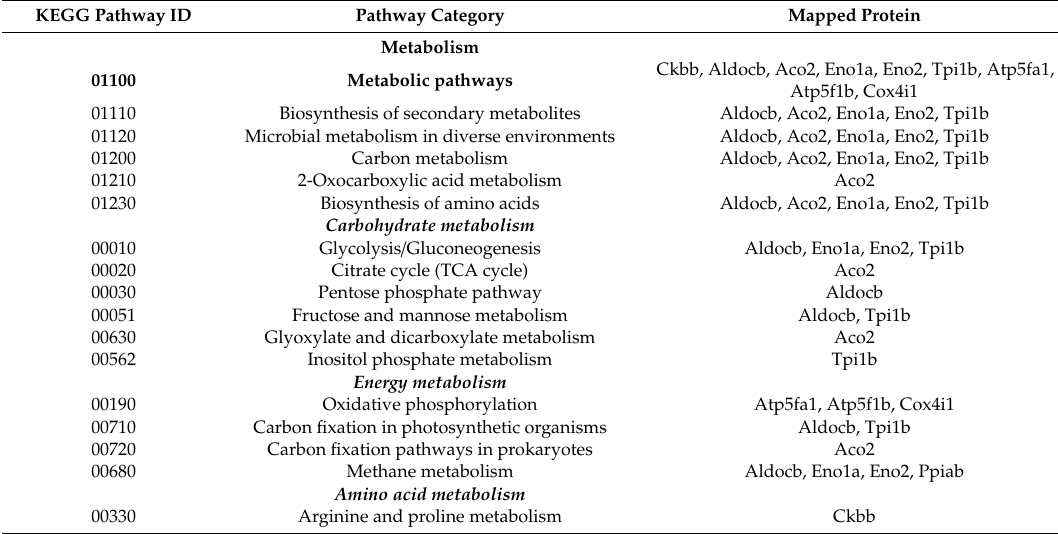
Figure 10. BiNGO result for molecular function as visualized in Cytoscape (Organism: Danio rerio ). Colored nodes are significantly overrepresented. White nodes are not significantly overrepresented; they are included to show the colored nodes in the context of the GO hierarchy. Color key on the bottom right indicates the significance level of overrepresentation. Table 6. KEGG pathways (Organism: Danio rerio ) associated with the di ff erentially expressed proteins identified from negative control (NC, PTZ 170 mg / kg only) and O + P (OSLP 800 µ g / kg + PTZ 170 mg / kg) zebrafish